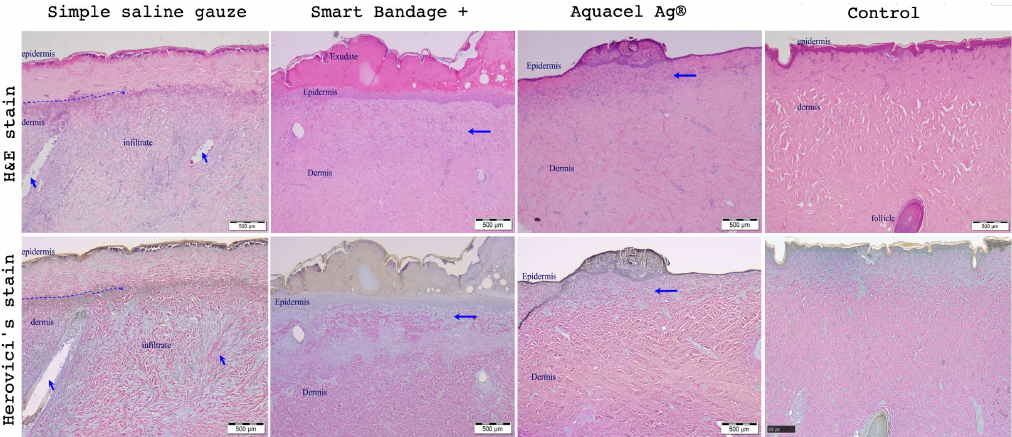
Figure 5. Histological representative wounds (out of total n = 18) evaluation on day 21, end of the study. Simple saline gauze, Smart Bandage+ (INTELIGELS Ltd. Hoshaya, Israel), and Aquacel ® treated wounds. Hematoxylin, Eosin, and Herovici’s stains were used to evaluate wound healing and reactive fibrosis. In the simple saline gauze samples, the blue dotted line on the left indicates the area of persistent epidermal and superficial dermal necrosis. The arrows indicate two necrotic hair follicles. There is underlying diffuse dermal cellular infiltration. The tissue is viable in the Smart Bandage+ (INTELIGELS Ltd. Hoshaya, Israel) and Aquacel Ag ® samples. As a result, there is epidermal regeneration and epidermal hyperplasia. The horizontal blue arrow on the right indicates the area of superficial dermal fibrosis. In the Smart Bandage+ (INTELIGELS Ltd. Hoshaya, Israel) sample, there are two necrotic follicles on both left and right margins of the photo. The control slide made at day 0 represents a complete thermal necrosis of the epidermis; the underlying hair follicle is viable. There was necrosis of the more superficial adnexa. There is no sloughing of the epidermis, inflammation, or regeneration attempts.